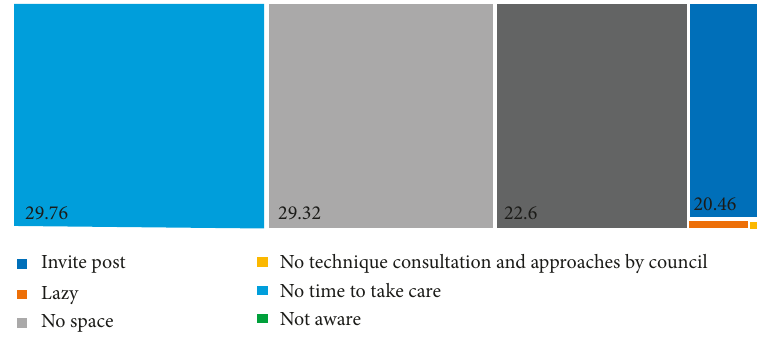
Figure 13: Willingness to have a composting pile at